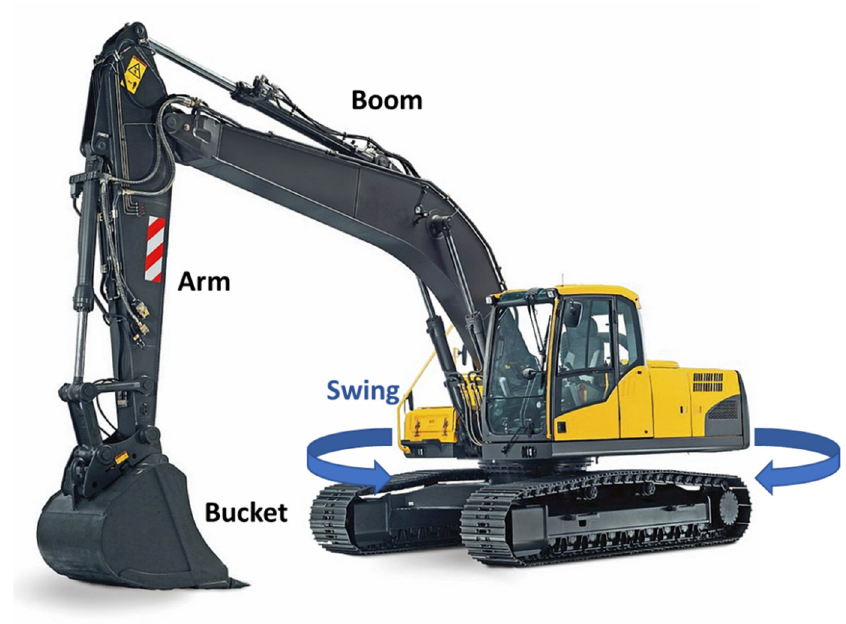
Figure 4. A wheeled excavator shown with its major components. The swing motion allows this equipment to rotate 360 degrees without engaging the drivetrain.